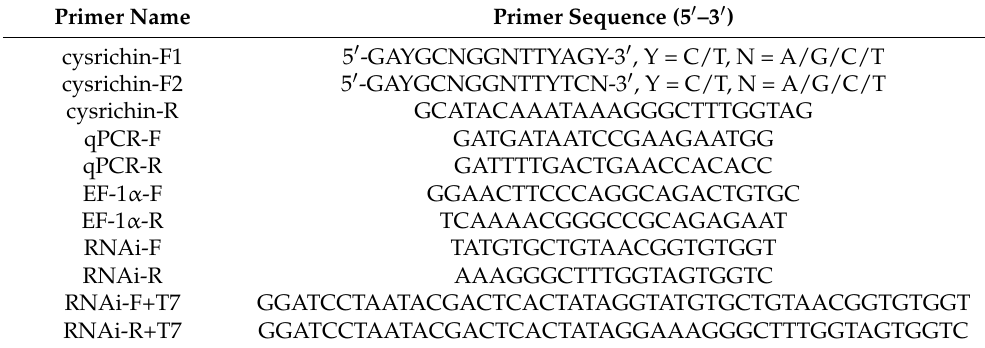
Table 1. Primers used in this